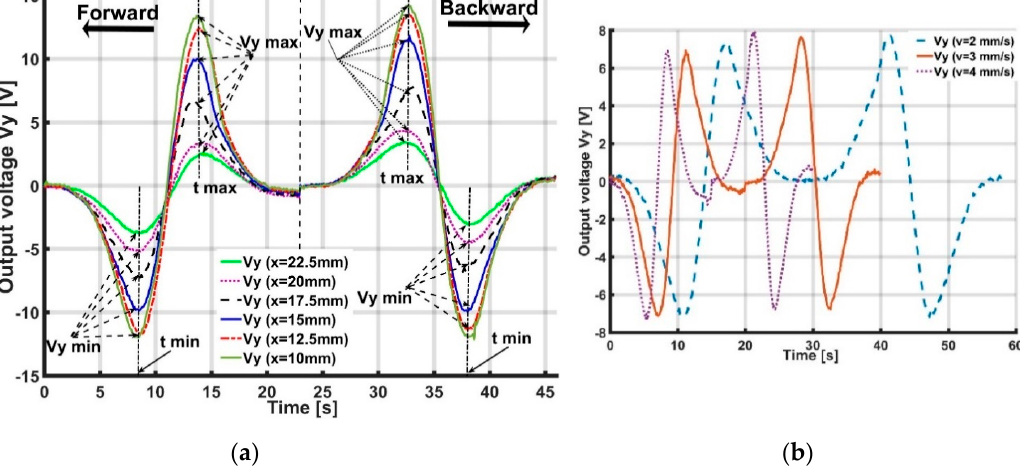
Figure 16. Output voltage V y of accelerometer with Y-sliding when distance x increases from 10 to 22.5 mm. Values of V y min , V y max only depend on distance x and t min , t max depends on magnitude of velocity v . Based on accelerometer’s output voltage, distance x from accelerometer to sliding line and magnitude of velocity v can be estimated. ( a ) Output voltage V y ( V ) with di ff erent distances x ( mm ) . ( b ) Output voltage V y ( V ) with di ff erent velocities v ( mm / s ) .